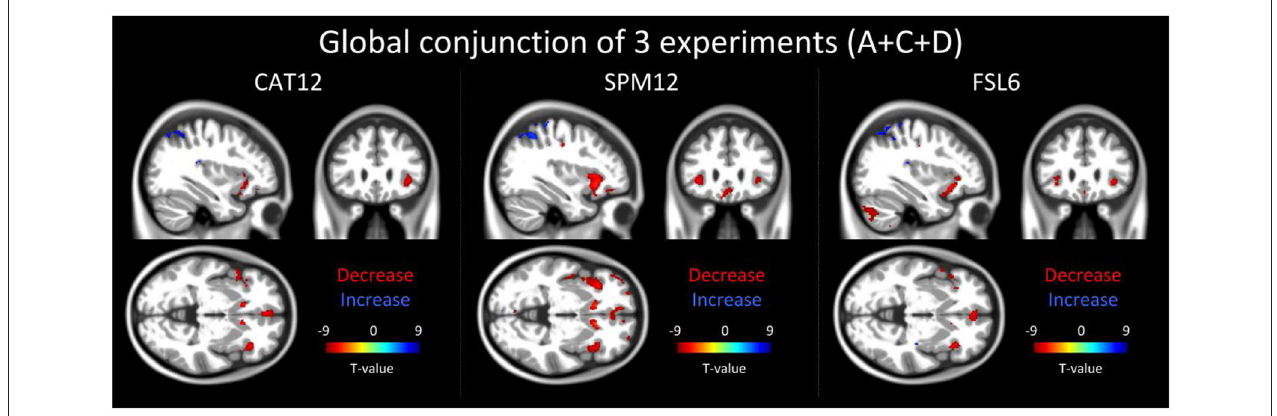
FIGURE 3 | The result of the global conjunction test across all three reported experiments (20 participants for each experiment) is shown in 3 orthogonal slices (xyz − 34 27 − 2mm) for three different software packages: CAT12, SPM12 and FSL6. Global conjunction tests where the differences between the time points were consistently high and jointly significant across all three experiments (A + C + D) using a minimum statistic. Decreases in gray matter of structural magnetic resonance images are displayed in red colors while increases are indicated by blue colors.